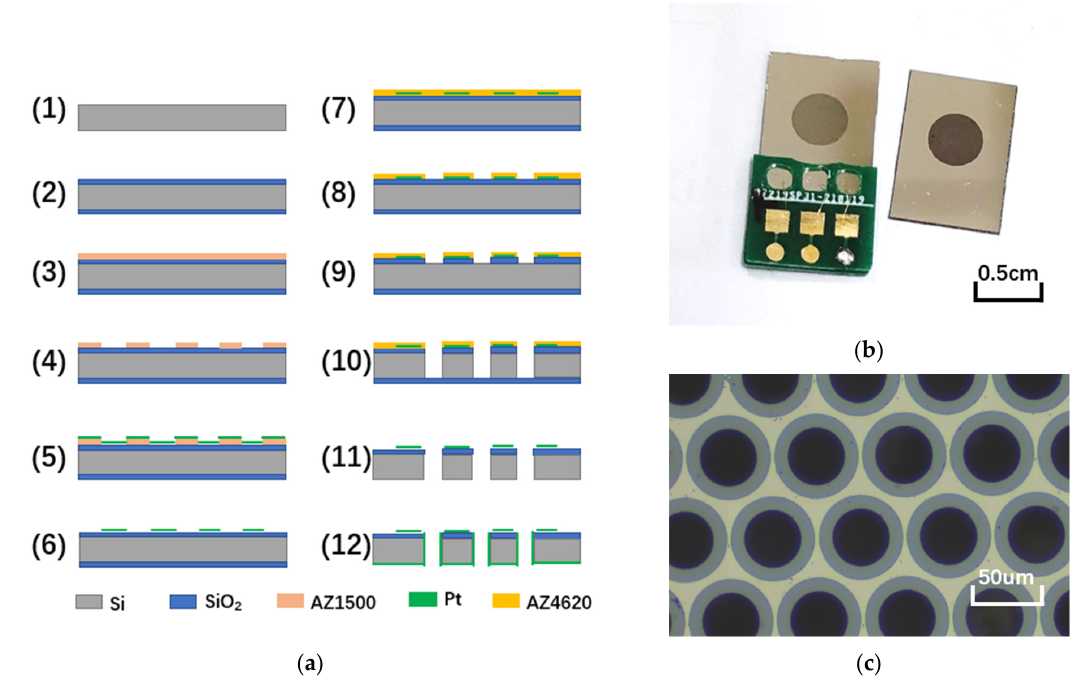
Figure 4. Manufacturing process of sensitive electrode. ( a ) Manufacturing process of sensitive electrode based on a micro-electro-mechanical system. ( b ) The finished electrode (right) and the electrode after pasting PCB (left). ( c ) Microscopic observation of flow holes in sensitive electrodes.